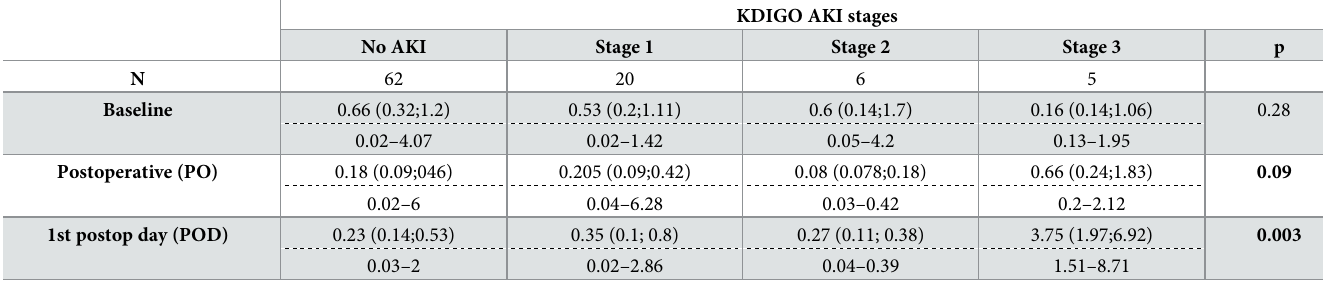
Table 4. Comparison of (TIMP-2) x (IGFBP7) along KDIGO AKI